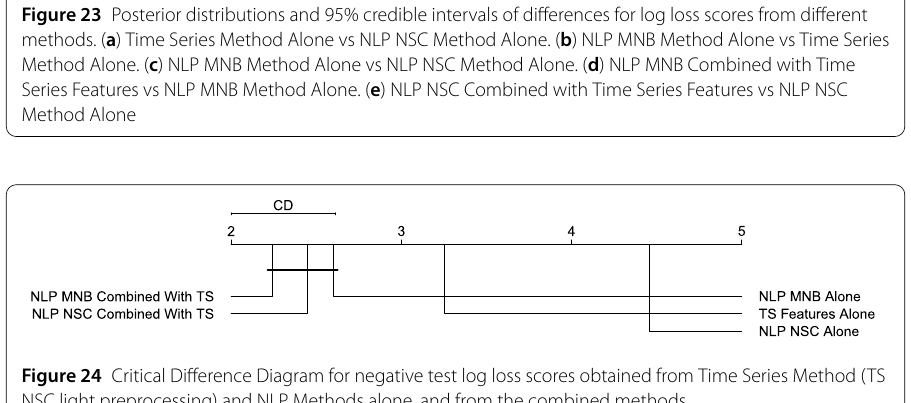
TLS__mean with a p -value of 1.581 · 10 –24 . In this section, we will show that both features describe the differences in the mean token length between sentences, and the TLS__c3__lag_1 feature also captures some variances in non-linearity of the token length sequence time